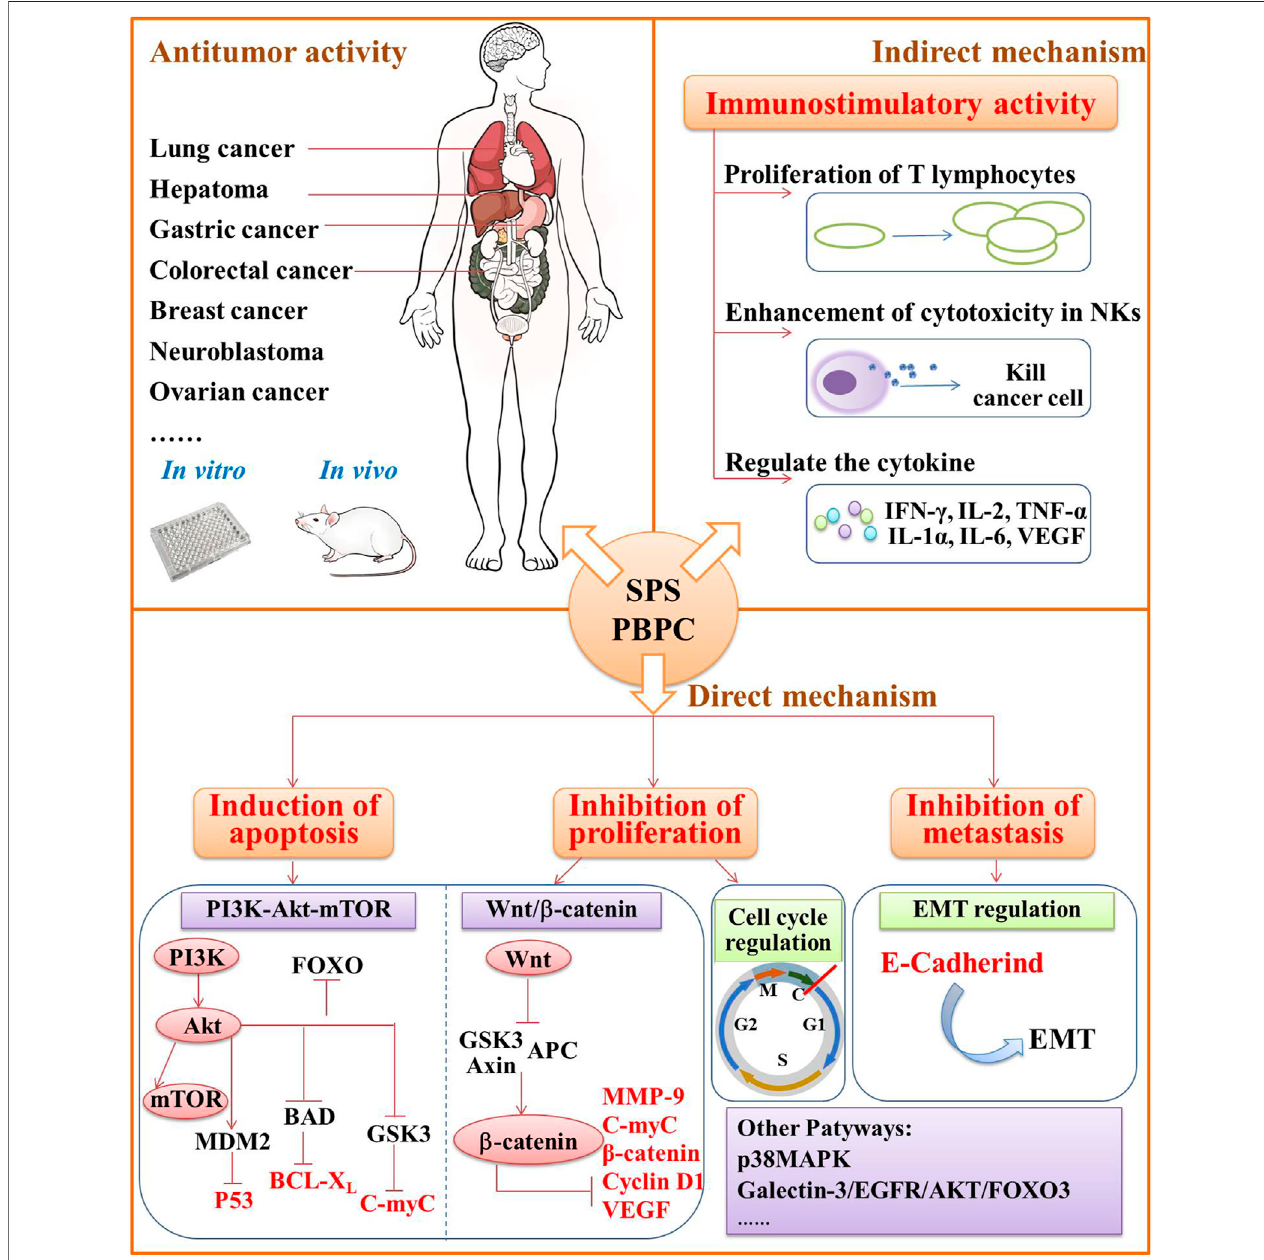
FIGURE 5 | Schematic diagram of antitumor mechanism schematic diagram of in SPS and PBPC.